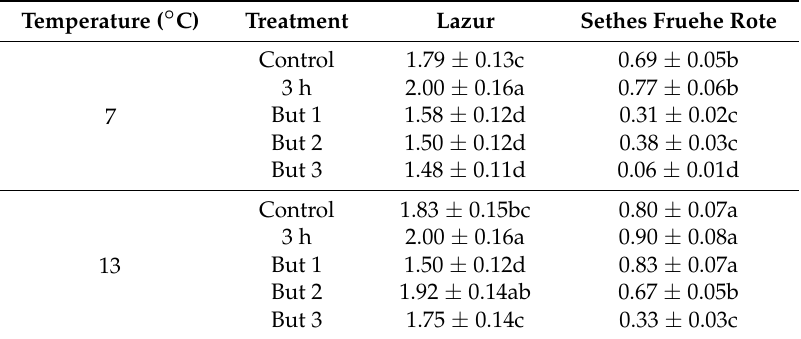
Table 6. Effects of pre-sowing treatments on generative development (GD) of two L. angustifolius cultivars germinated and grown for the first four week at 7 ◦ C or 13 ◦ C. Control—plants grown from seeds germinated in water; 3 h—plants grown from seeds hydroprimed for 3 h at 20 ◦ C; But 1, But 2, But 3—plants grown form seeds germinated in the presence of 10 − 6 M, 10 − 5 M, 10 − 4 M butenolide,